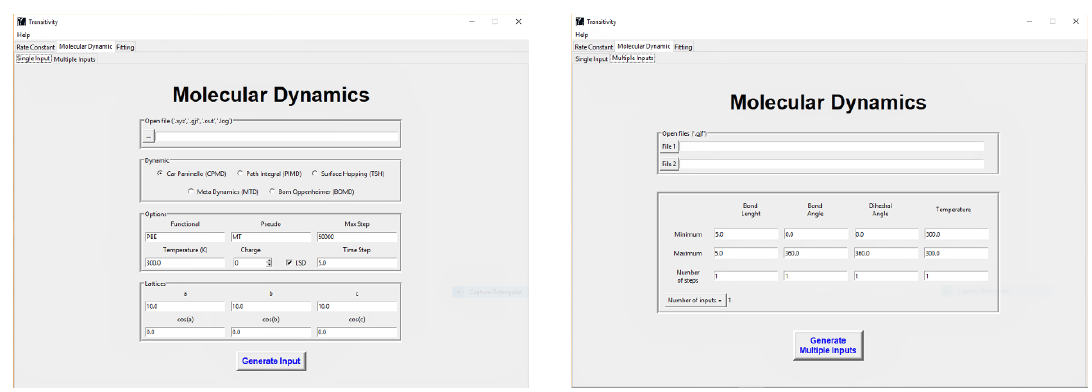
Figure 6. An exemplary view of the input generation function of the transitivity program. Details of input files can be found in the www.vhcsgroup.com/transitivity web page.